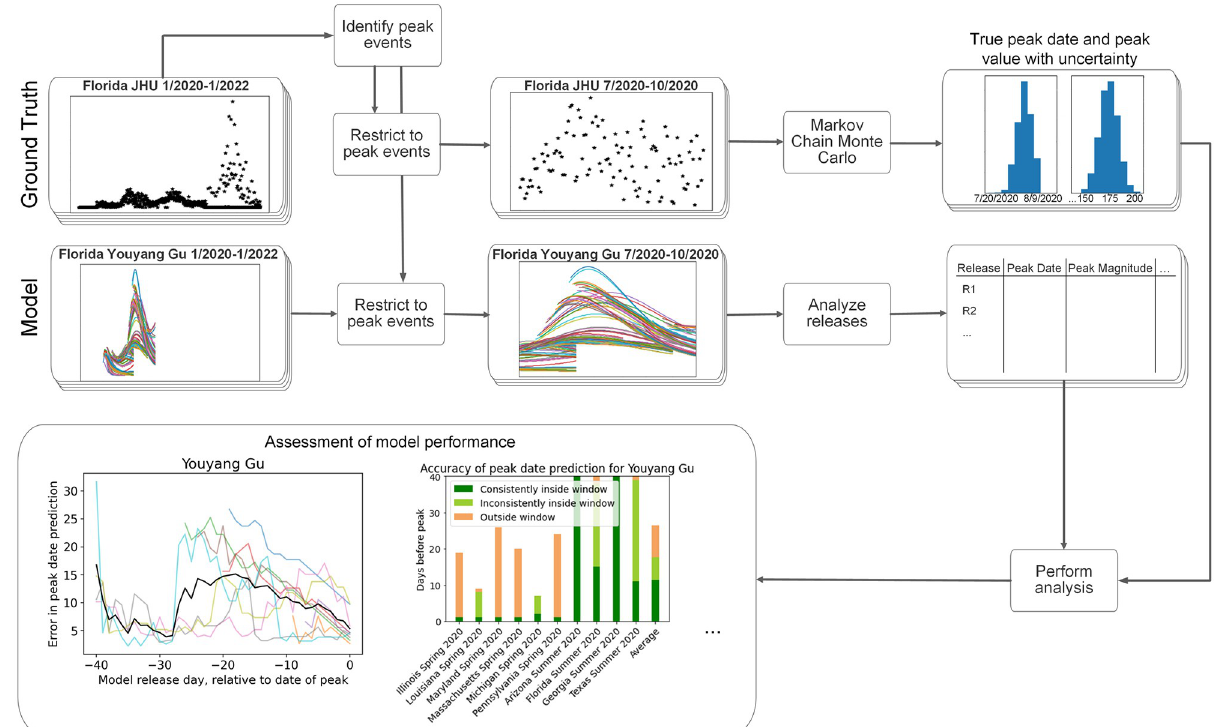
Fig 1. Workflow of model validation framework. Peak events are identified from the ground truth, which are then analyzed to determine peak dates and peak magnitudes (and other quantities). Uncertainty in this quantities is accounted for. Simultaneously, model predictions for the peak events are analyzed, and each release’s prediction of peak date and magnitude is identified. The collected information are then analyzed to obtain measures of the performance of the model for each peak